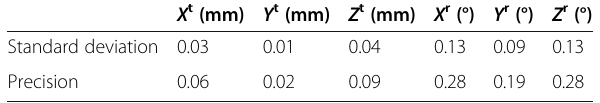
Table 1 Precision based on the 0° rotation double-exams ( n =